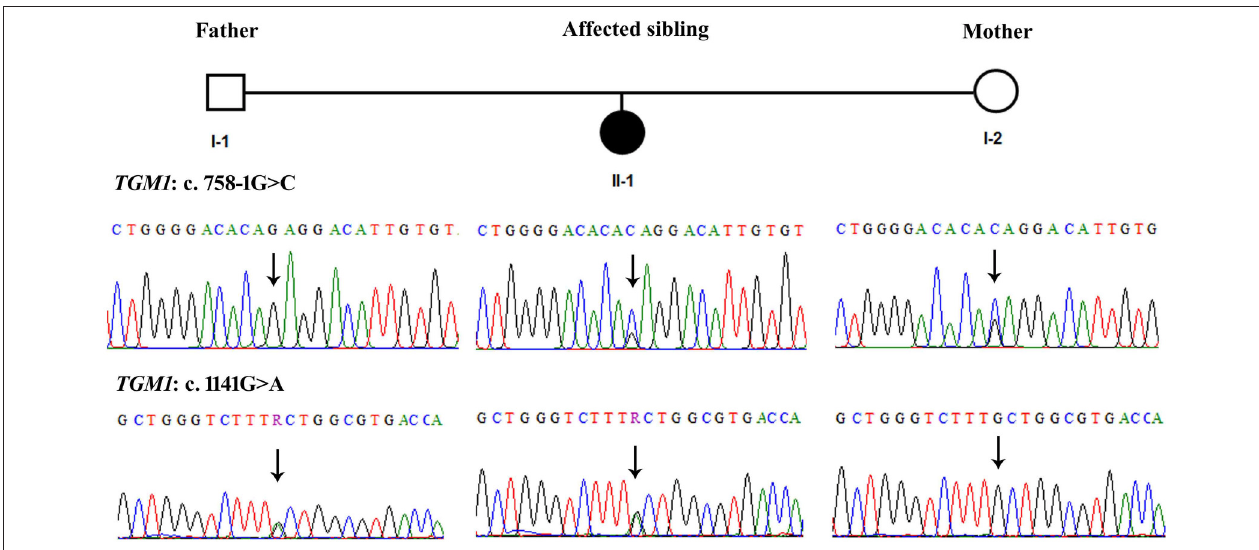
FIGURE 2 | Sanger sequencing of the TGM1 variants showing segregation of c.758-1G > C (Intron4-Exon5 boundary) from mother and c.1141G > A (Exon 7) segregation from father. The arrows indicate respective nucleotides in the sequences. Right panels show that father is wild type for c.758-1G > A and carrier for c.1141G > A. The right panels show that mother is carrier for c.758-1G > A and wild type for c.1141G > A. The middle panels show that affected sibling has both variants in heterozygous